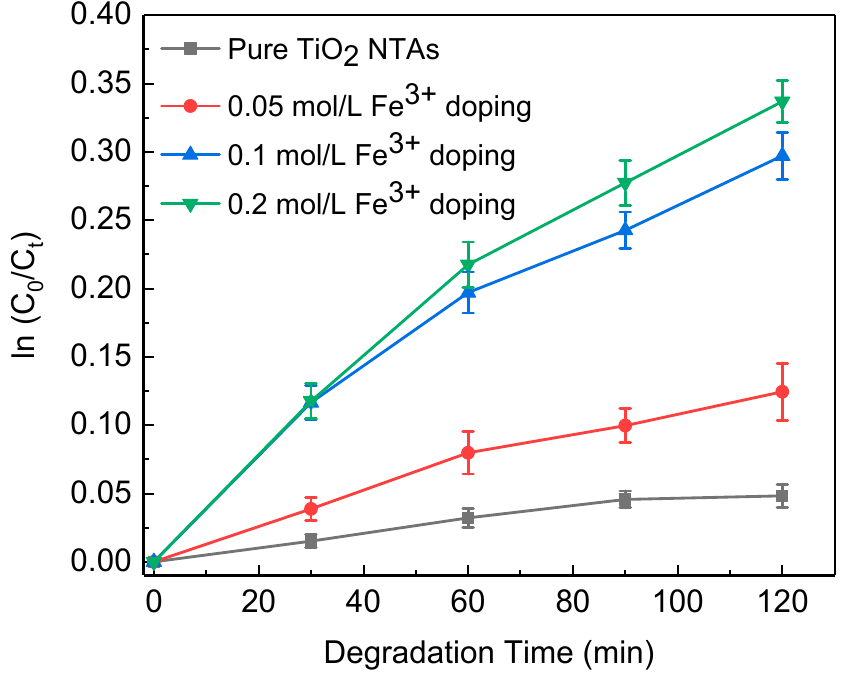
Figure 8. Concentration change of MO as a function of irradiation time under visible light for pure and Fe 3+ doped TiO 2 NTAs.